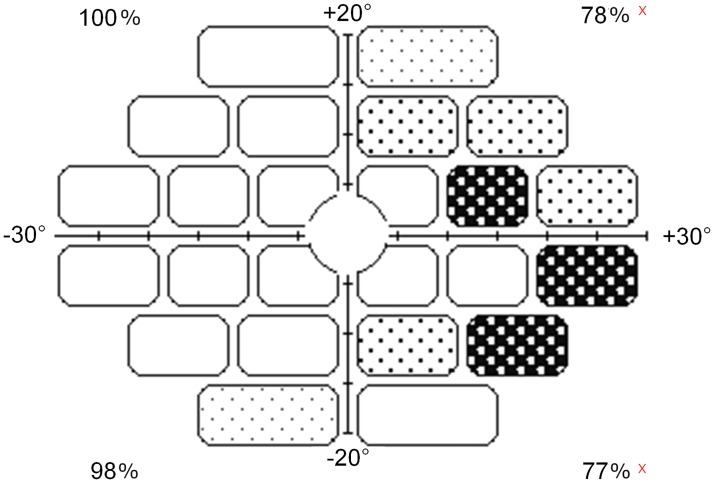
Example of outcome from Rarebit perimetry.A white rectangle indicates that all dots are perceived. The shading represents a larger proportion of non-perceived dots in that particular location (see manual for more details). Numerical results are compared to normal limits. Results falling outside limits are marked with a x next to the percentage numbers. The outcome reported in Fig 1 represents a partial scotoma in half of the visual field in a patient (non-participant in this study) suffering from homonymous hemianopia.